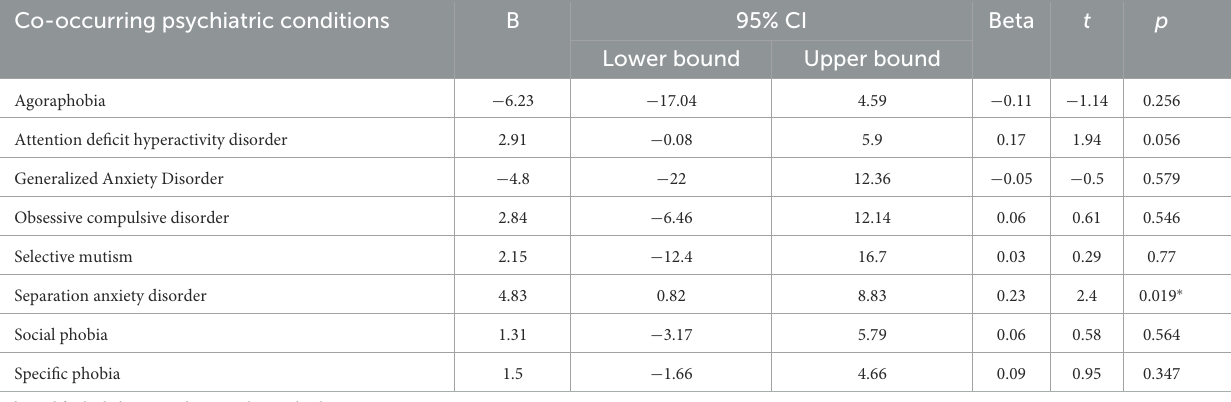
TABLE 4 Regression analysis using co-occurring psychiatric conditions to predict CSHQ total score. Co-occurring psychiatric